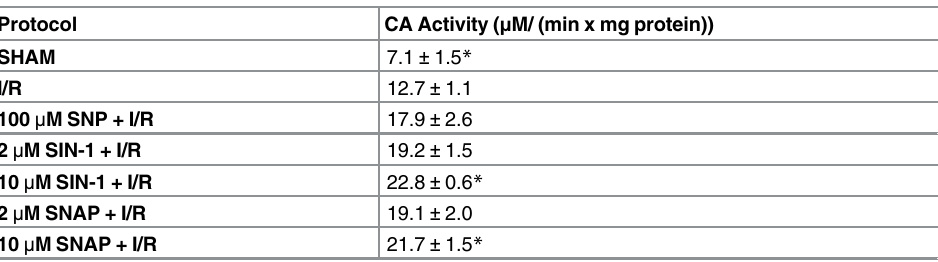
Table 4. Activity of cytosolic